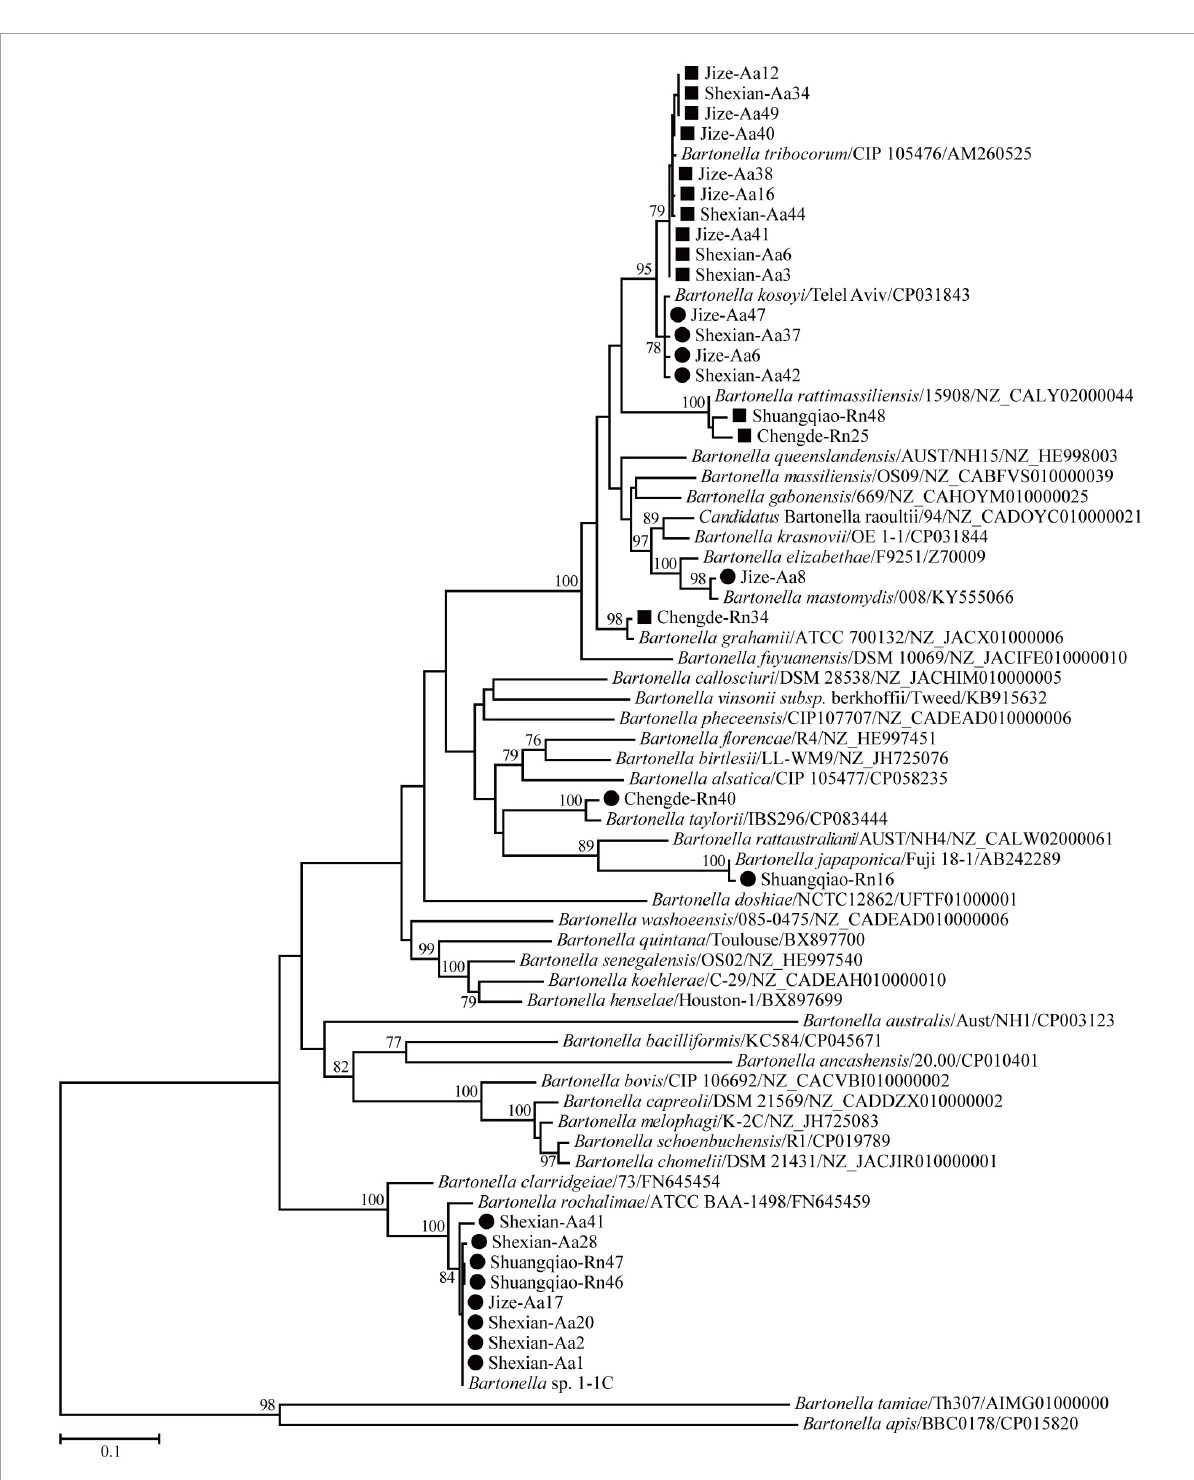
FIGURE3 Maximum-likelihood (ML) tree reconstructed based on the gltA gene sequences of Bartonella species. The legend follows that of Figure 2 .